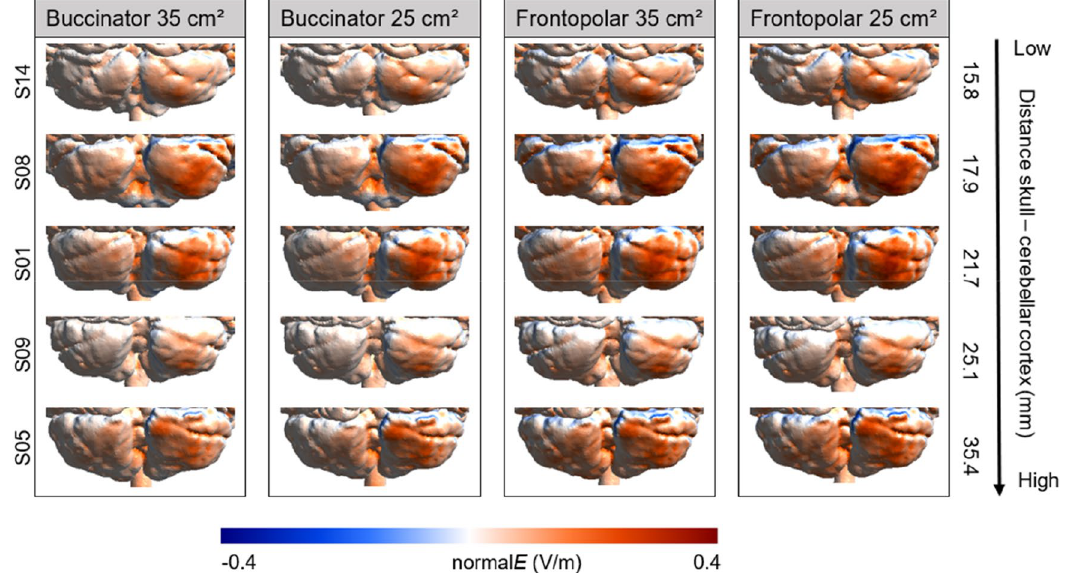
Figure 4. Field direction (normalE in V/m) for the four conventional electrode montages. Individual electric fields are depicted for five individuals representative of the range of scalp–cortex distance. Positive values (red) refer to current inflow and negative values (blue) refer to current outflow. An illustration of individual field directions of all individuals included in the study can be found in the “Supplementary Materials” (Fig.